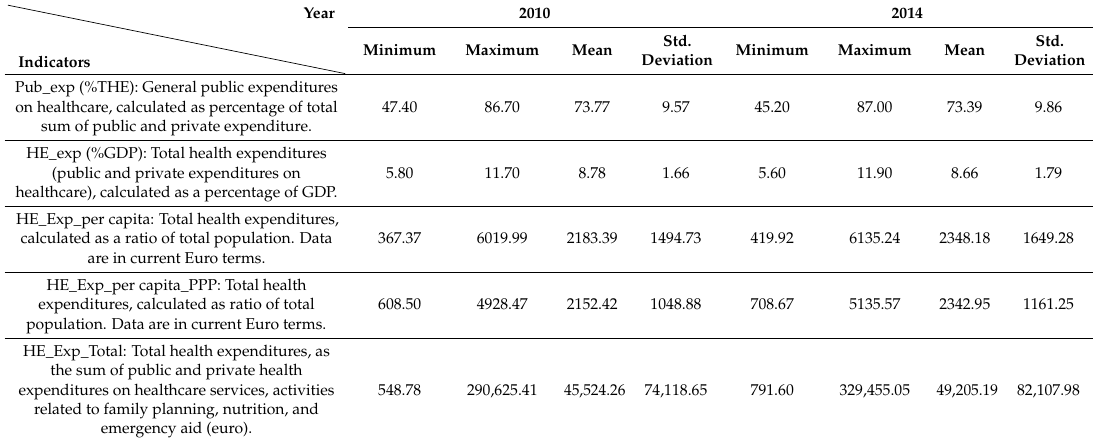
Table 2. Health care expenditure on all types of care (28 European Union (EU) member states), 2010 and